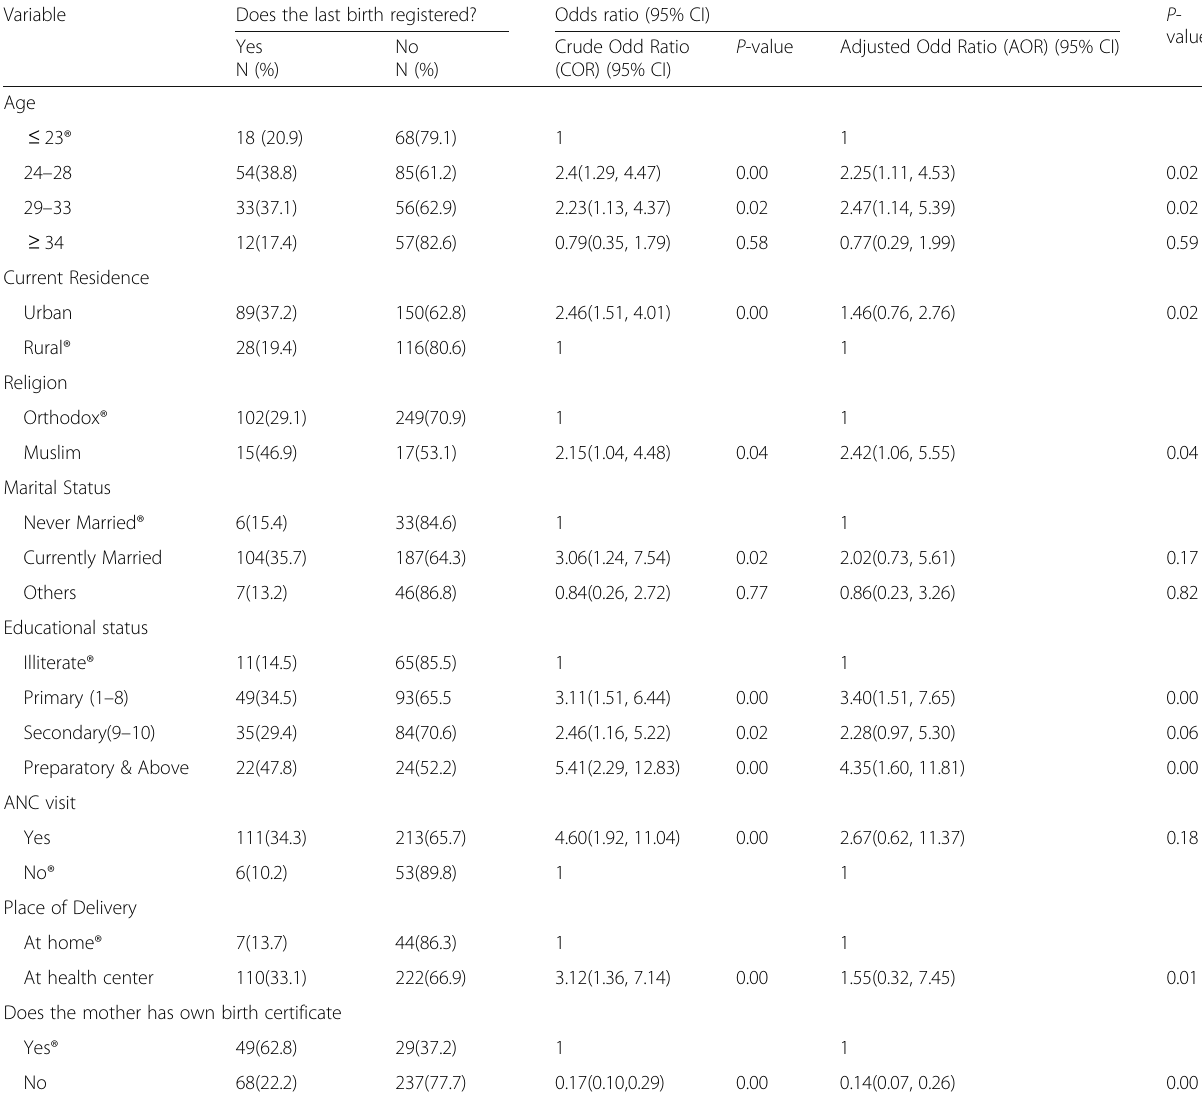
Table 4 Associated factors of birth registration among mothers who had given birth to at least one child since August 2016, Tigray Region, Ethiopia; May,